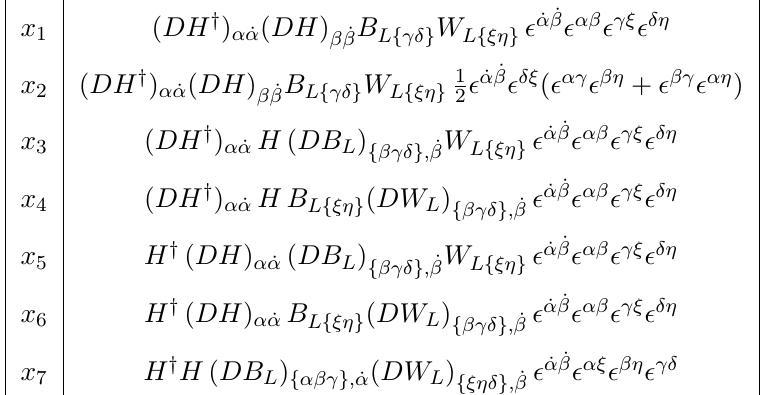
Table 2 . Operators of the type D 2 ( H y HB L W L ) where we have ignored IBP relations between terms. We have neglected all SU(2) w indices since there is only one possible contraction.